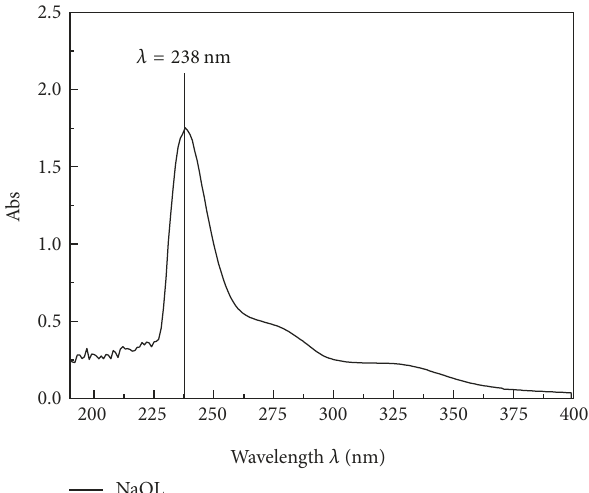
Figure 5: UV-Vis spectrum of NaOL (test concentration 0.20%).